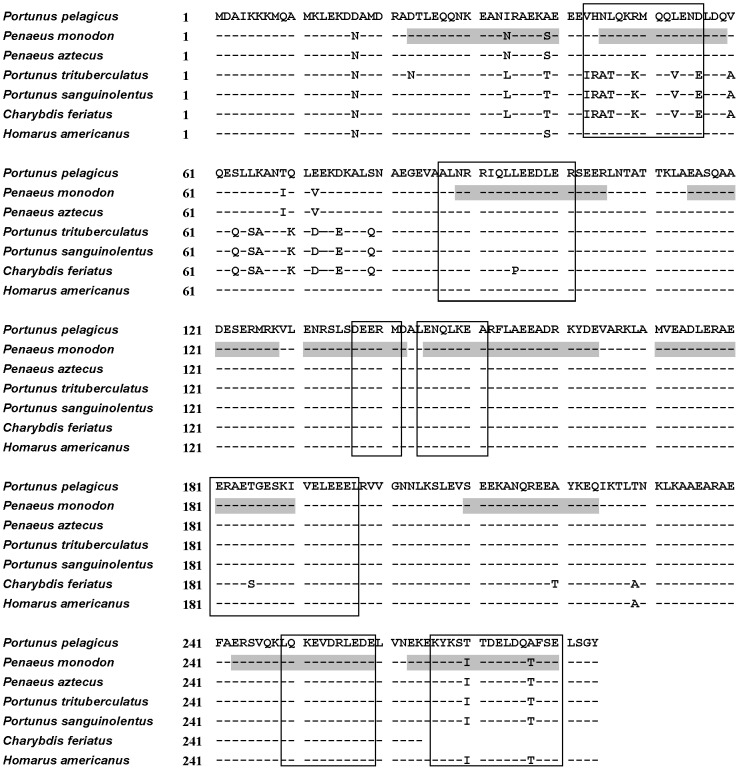
Tropomyosin sequence alignment.Alignment of TM sequences with Portunus pelagicus (blue swimmer crab) TM, Por p 1 (Genbank accession number JX874982.1), as reference using NCBI Protein BLAST. Species include Penaeus monodon (NCBI protein database accession number: A1KYZ2.1), Portunus trituberculatus (ABL89183.1), Portunus sanguinolentus (ABS12234.1), Charybdis feriatus (Q9N2R3.1) and Homarus americanus (AAC48288.1). Sequences that correlate with known linear epitopes of Penaeus aztecus TM (Pen a 1) [26]–[27] are boxed. Predicted linear IgE epitopes based on studies with Penaeus monodon TM (Pen m 1) [28] are shaded grey.